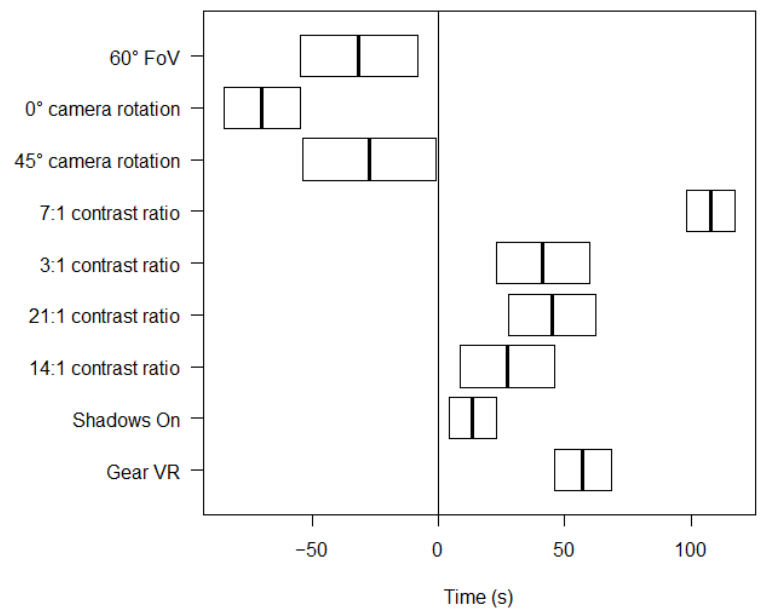
Figure 2. 95% CIs of each significant factor.